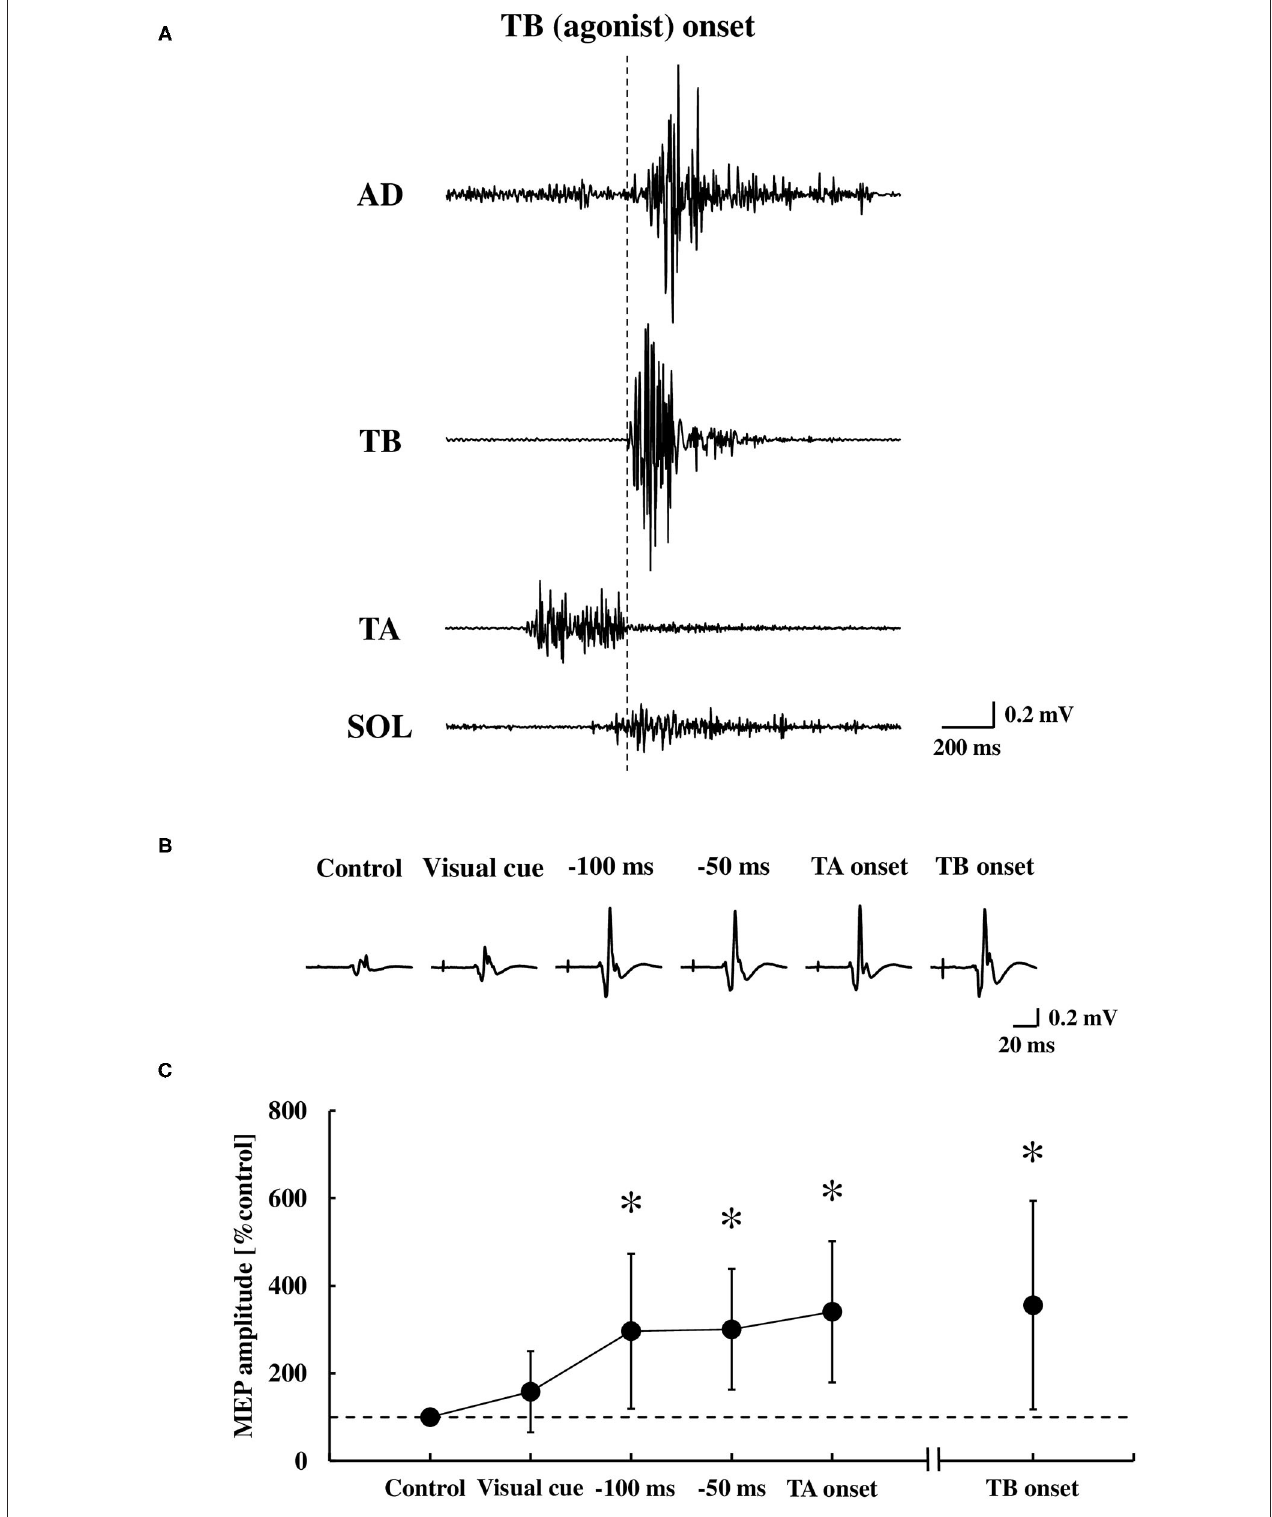
FIGURE 5 | Original tracings demonstrating the AD, TB, TA, and SOL muscle in the EMG activities during the dart throwing (A) , representative recordings of the MEP in the TA muscle (averaged five trials, respectively) (B) , and the average changes at the time points tested (C) ( n = 13). Error bar indicates the SD. * p < 0.01 significant difference from the control or visual cue. AD, anterior deltoid; TB, triceps brachii; TA, tibialis anterior; SOL, soleus; MEP, motor evoked potential.